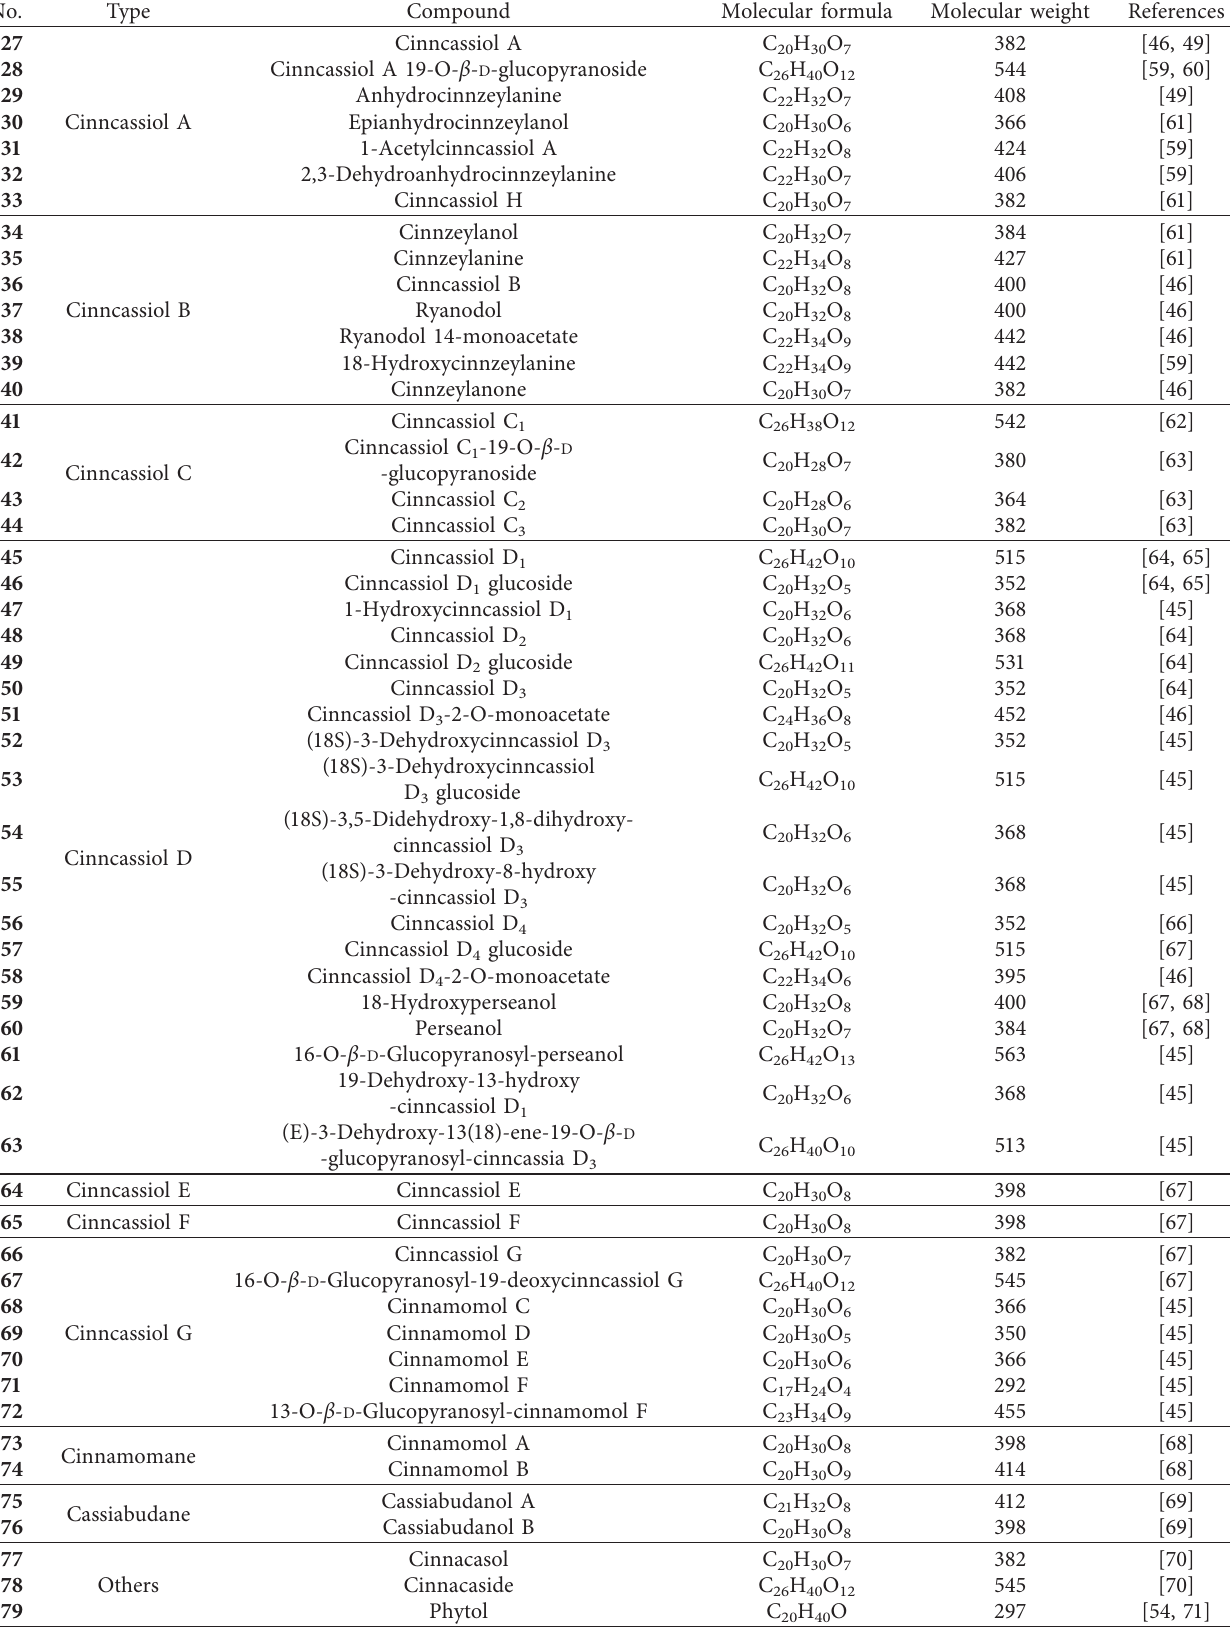
Table 3: Diterpenes from the genus Cinnamomum .